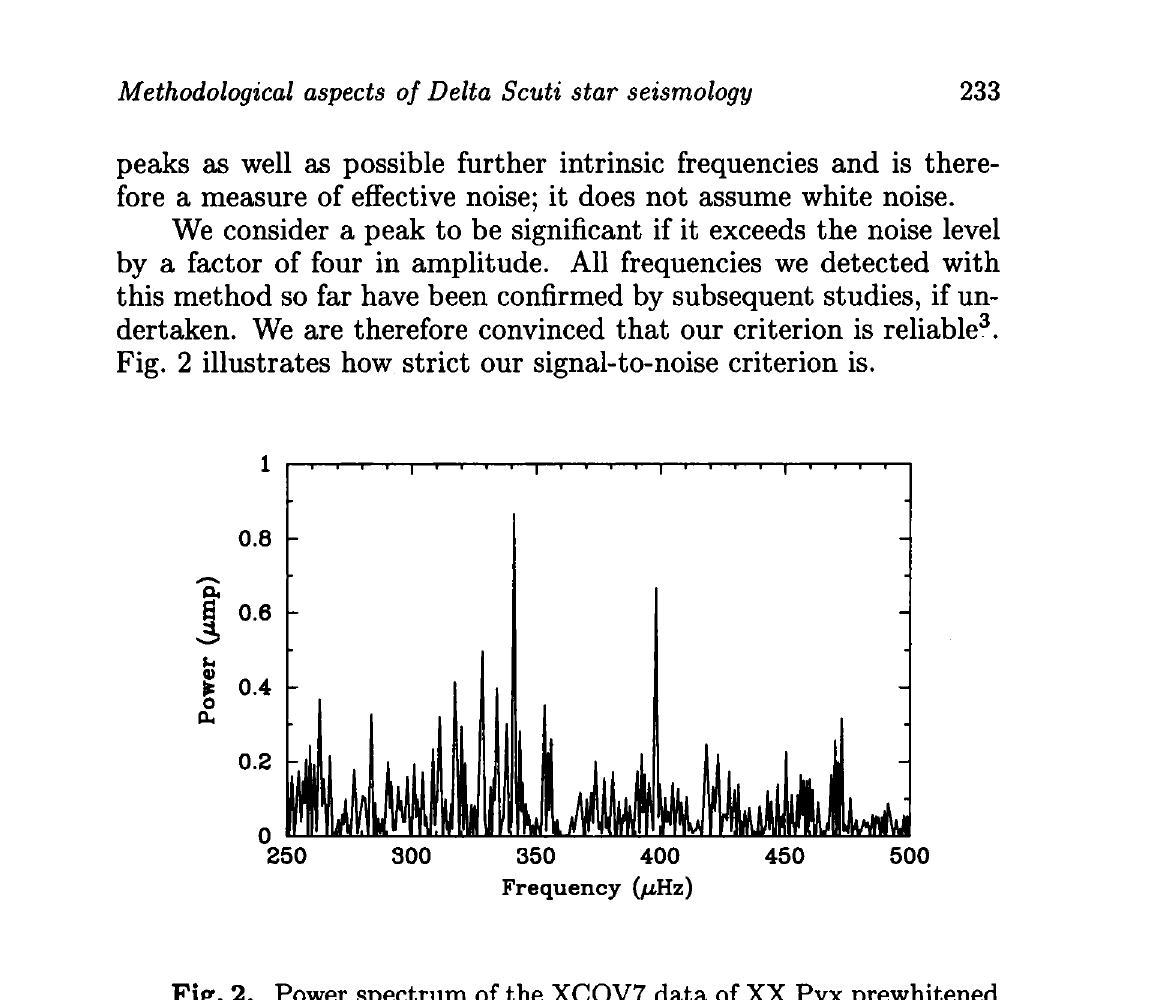
Fig. 2. Power spectrum of the XCOV7 data of XX Pyx prewhitened by 13 frequencies. Two peaks near 340 and 400 μΗζ clearly exceed the noise level. Our signal-to-noise criterion suggests they are not